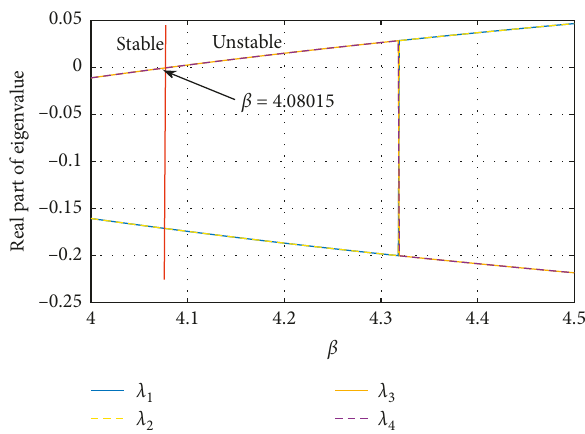
Figure 3: Stability of the equilibrium point for various values of β